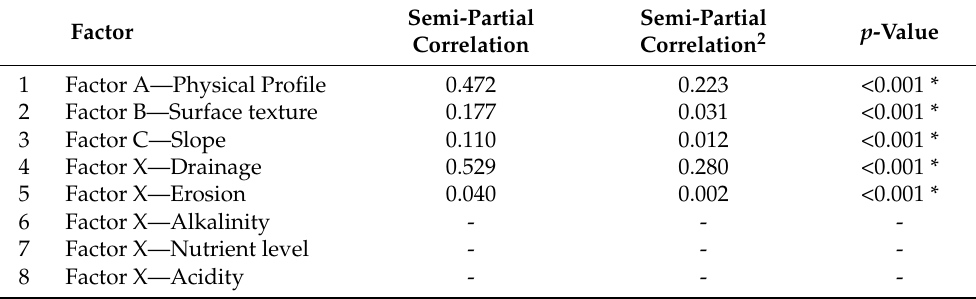
Table 2. Semi-partial correlation and squared semi-partial correlation of Storie soil factors with Storie suitability index values. Factors with zero variance were not included and are marked with a dash.